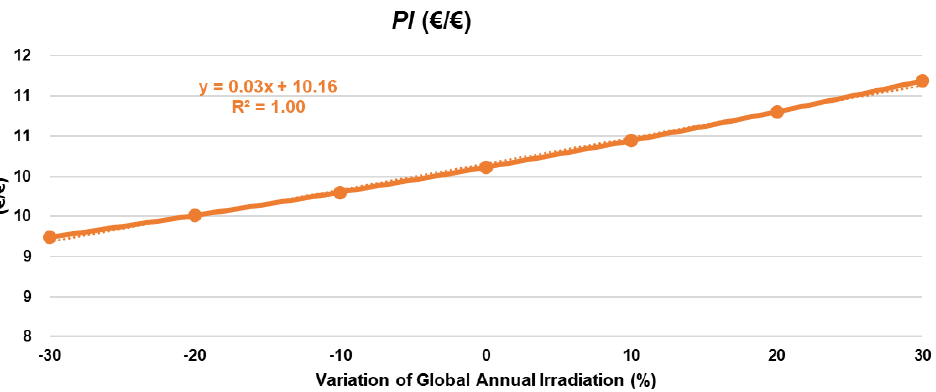
Figure 7. Profitability index of the PVDS obtained for a variation in the global annual irradiation between −3 0% and 30% from the base case value.